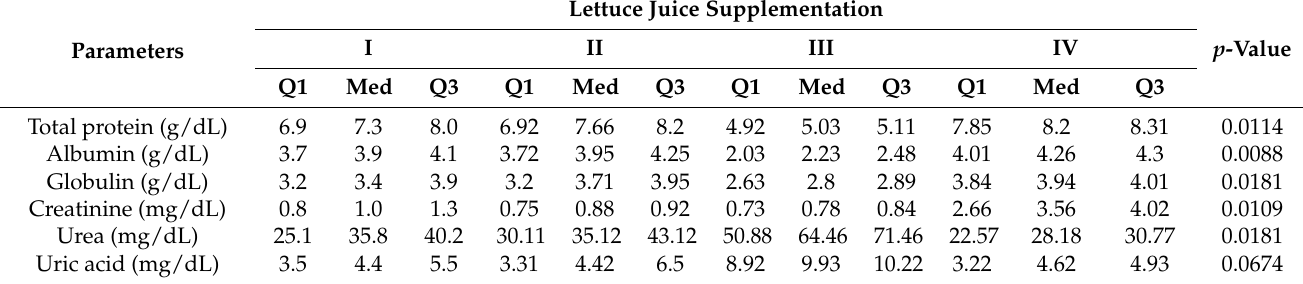
Table 8. Med, first, and third quartile (Q1 and Q3) of protein profile and kidney biomarkers in sera of rabbits administered nitrate- or WPH-fertilized lettuce juice (10 mL/animal daily) as compared to that of nonfertilized lettuce or lettuce-free diet (groups II and I,